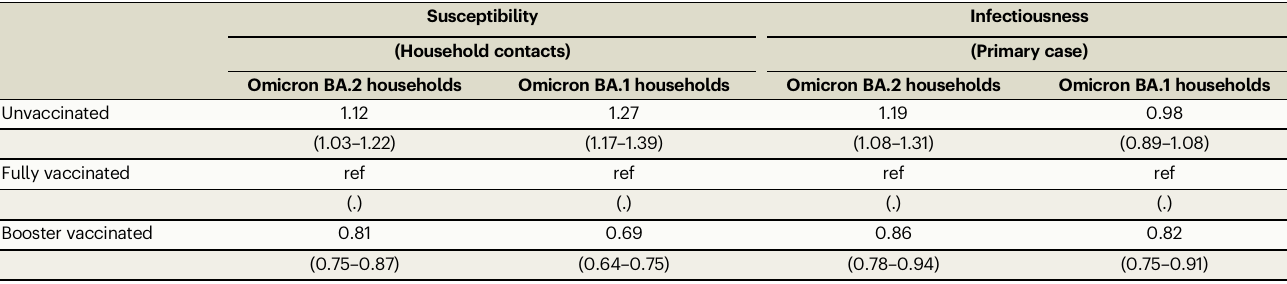
Table 2 | Effect of